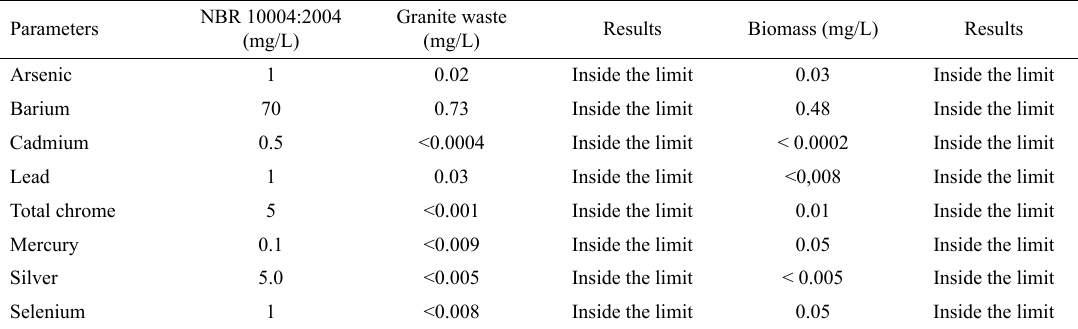
Table 4. Analytical results of the leaching